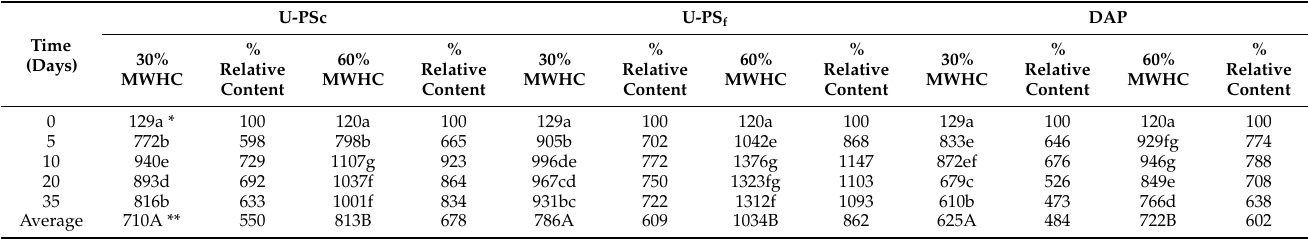
Table 7. Effect of incubation time and soil moisture on EC value ( µ S cm − 1 ) of soil solution under incubation of mineral fertilizers. Time (Days)